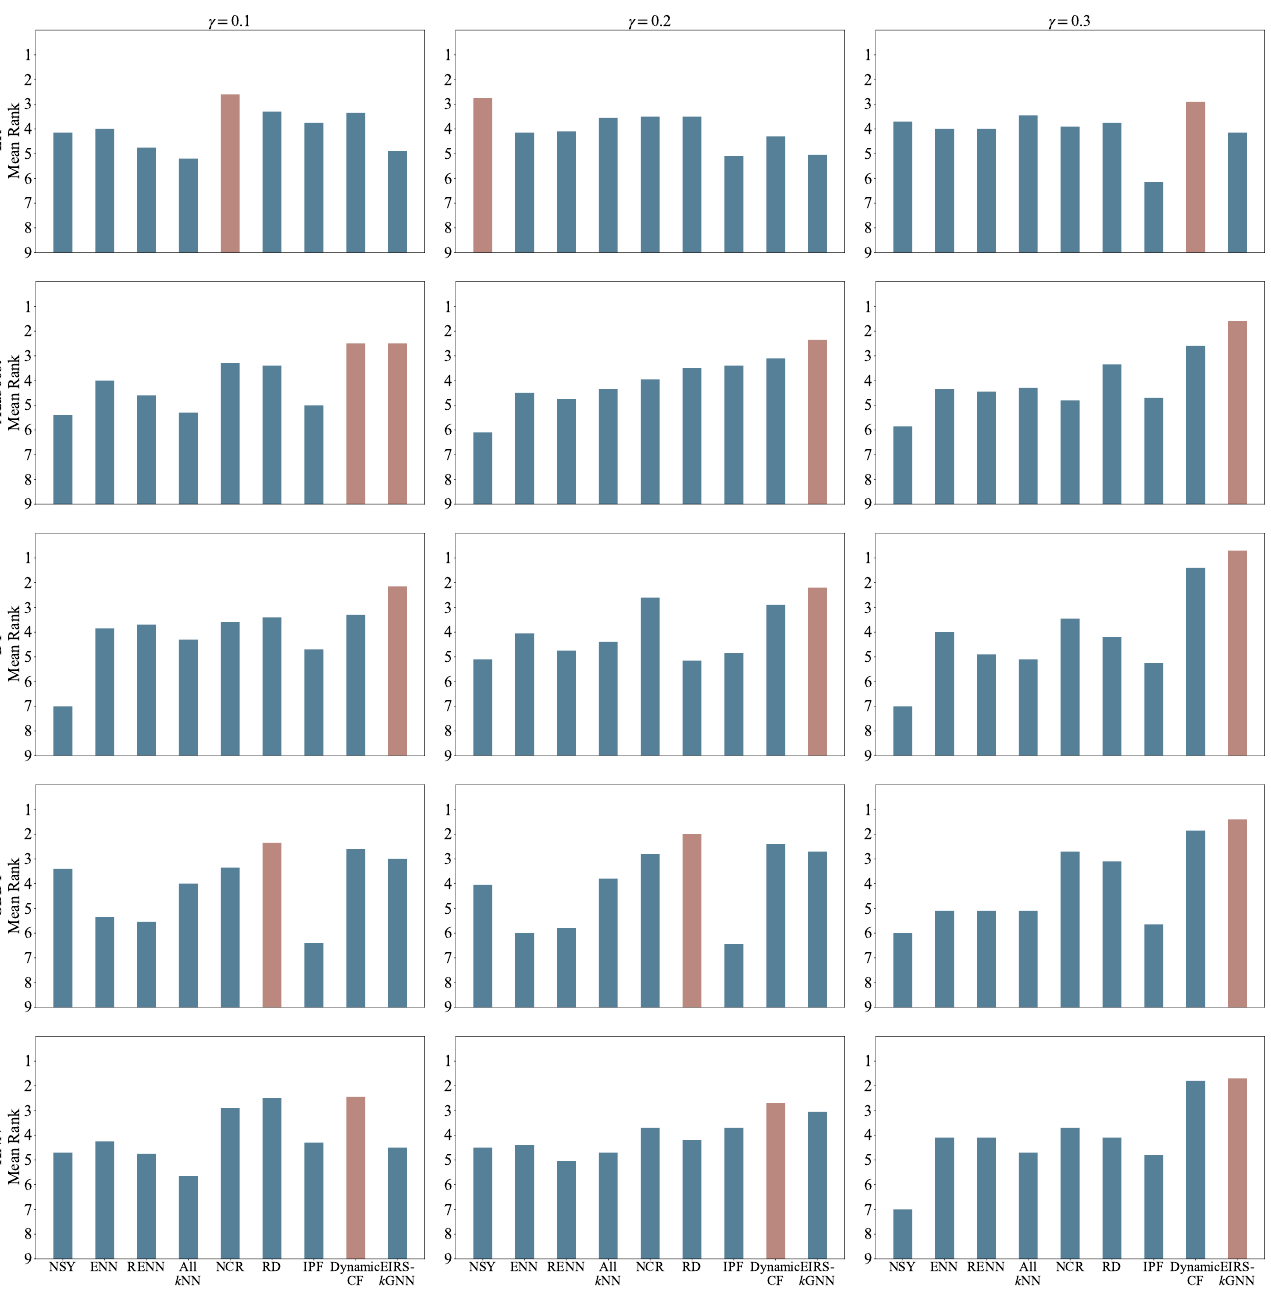
Figure 8. Mean ranks of various editing methods combined with different classifiers at varying γ . As shown in Figure 8, different methods achieved the best performance in different combinations with classifiers and at different noise rates. Classifying on the noisy data sets generally resulted in the worse classifying performance, especially at γ = 0.3. At γ = 0.1, NCR, RD, DynamicCF, and EIRS- k GNN showed improvements over others in the combinations with well selected classifiers: NCR combined with LR, RD with GBDT, DynamicCF with Adaboost and KNN, and EIRS- k GNN with Adaboost and DT achieved samples in the training set at the cost of some label noise remaining undetected. At the low level of noise rate, its superiority is not that significant. However, the advantages